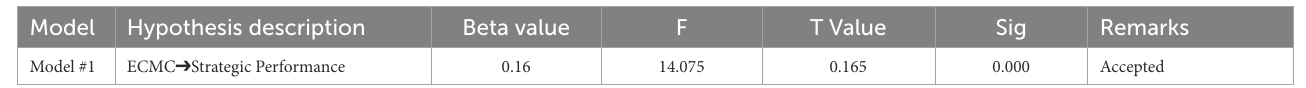
TABLE 4 E-commerce marketing capabilities and strategic performance.